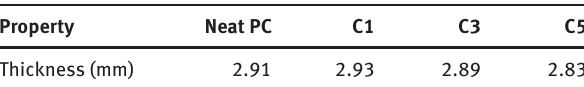
Table 7 Average thicknesses of injection molded electrical resistiv- ity specimens.